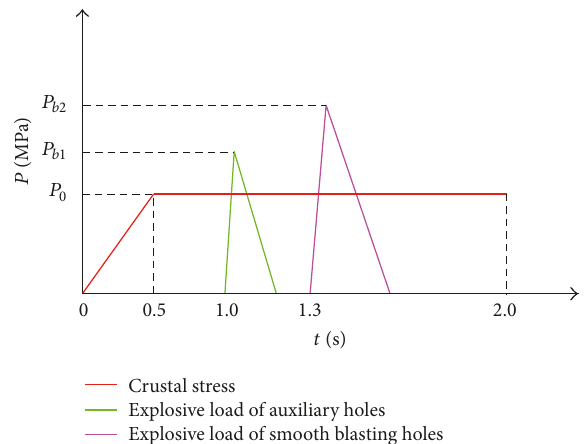
Figure 1: The curved diagram of explosion load.